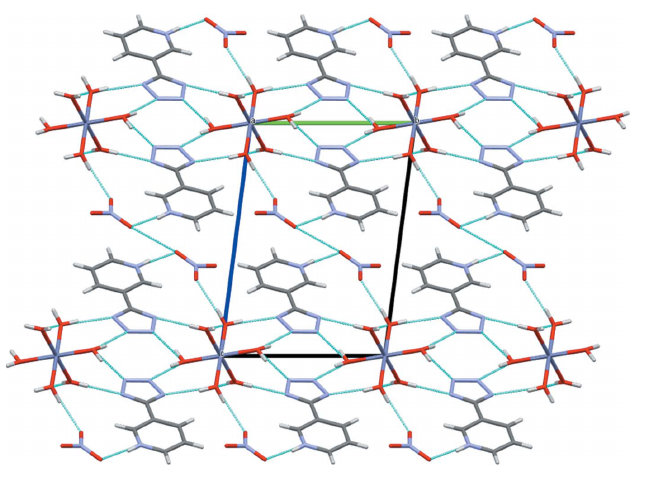
Figure 3 The crystal packing of the title compound, viewed along the [100] direction, showing O—H (cid:2)(cid:2)(cid:2) N and N—H (cid:2)(cid:2)(cid:2) O interactions (cyan lines).